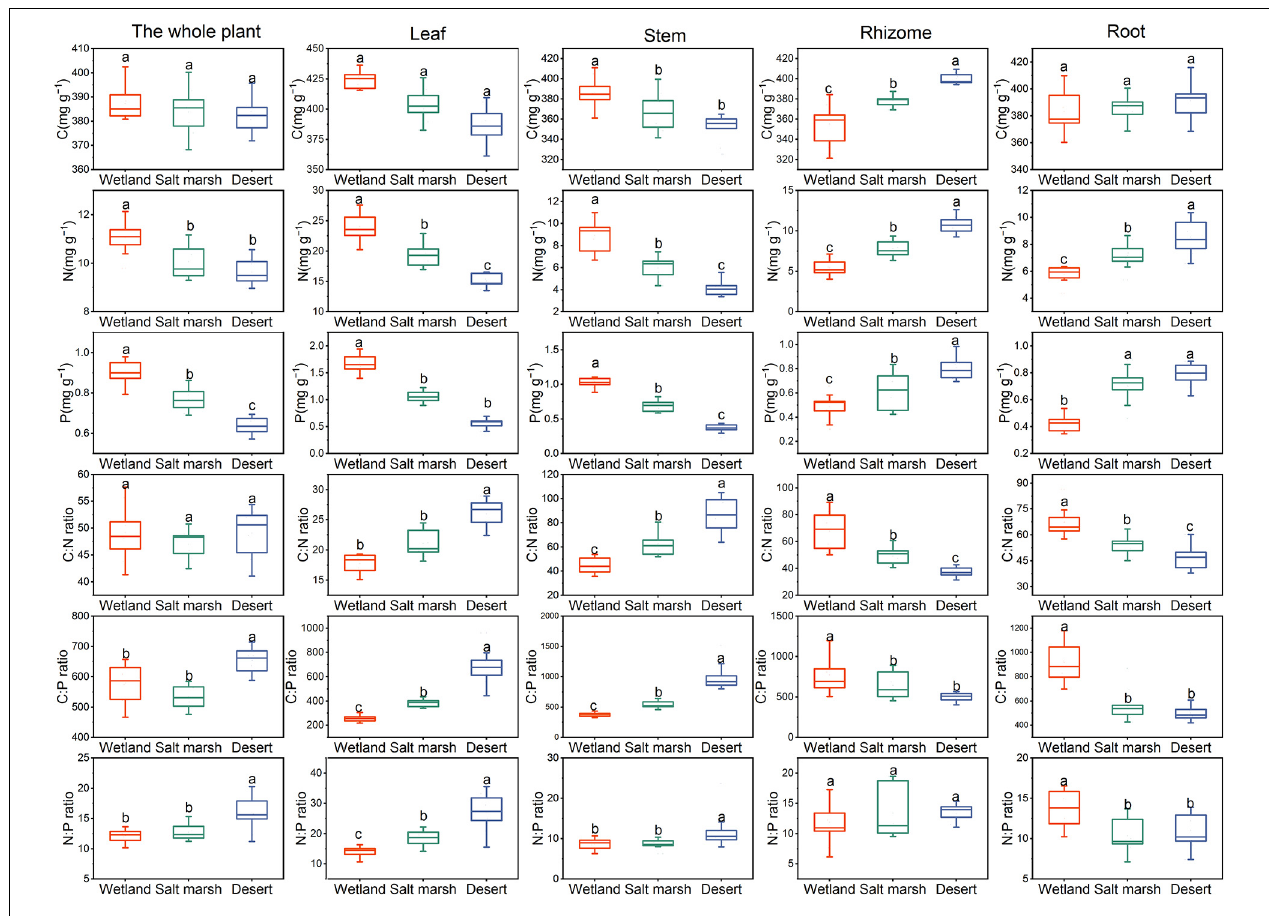
FIGURE 3 | The stoichiometry of P. australis under different habitats (means ± se, different lowercase letters indicate significant differences between habitat